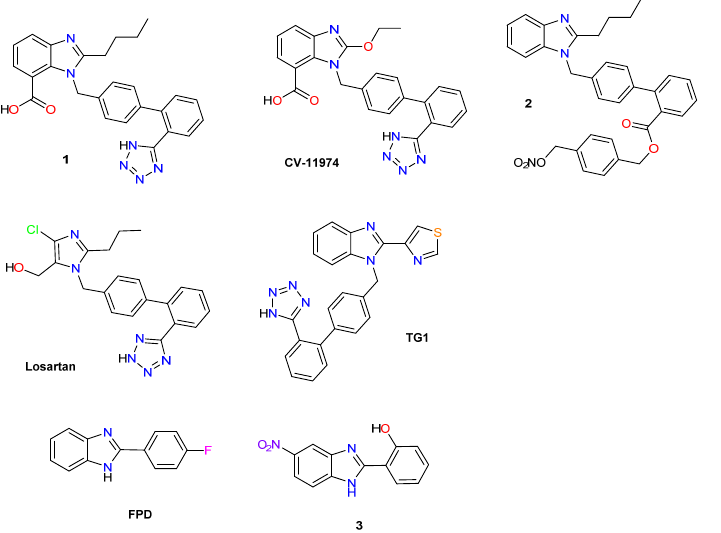
Figure 4. Selected examples of benzimidazole analogs bearing antihypertensive properties.